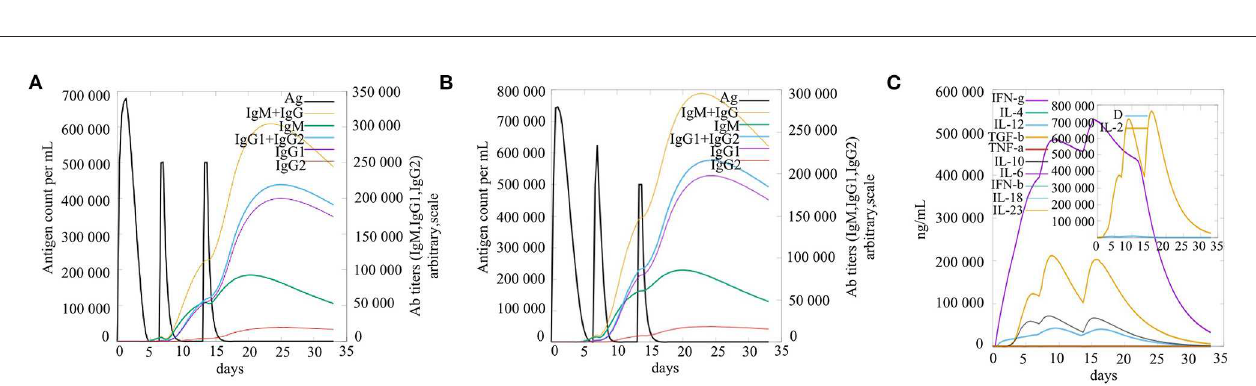
FIGURE11 Immunoglobulin and immune complex; Change trend of cytokines and interleukins. (A) Antigen and immunoglobulins, Antibodies are sub-divided per isotype ( β -Defensin I molecular adjuvant including); (B) Antigen and immunoglobulins. Antibodies are sub-divided per isotype ( β -Defensin I molecular adjuvant not including); (C) Concentration of cytokines and interleukins. Inset plot shows danger signal together with leukocyte growthfactor